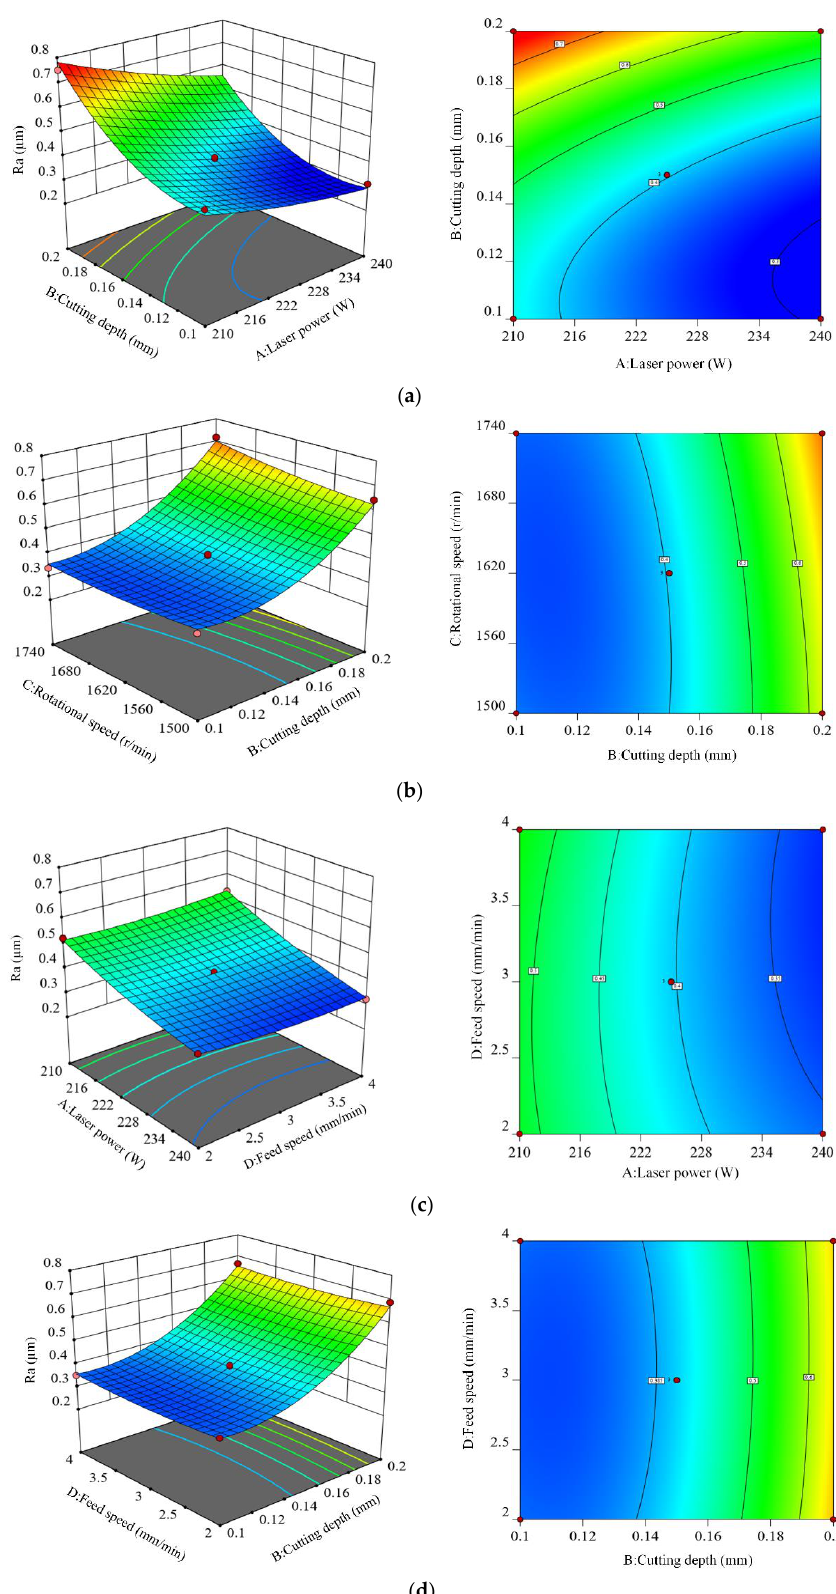
Figure 5. Three-dimensional surface and contour diagram. ( a ) Interaction of laser power and cutting depth, ( b ) Interaction of cutting depth and rotational speed, ( c ) Interaction of laser power and feed speed, ( d ) Interaction of cutting depth and feed speed.